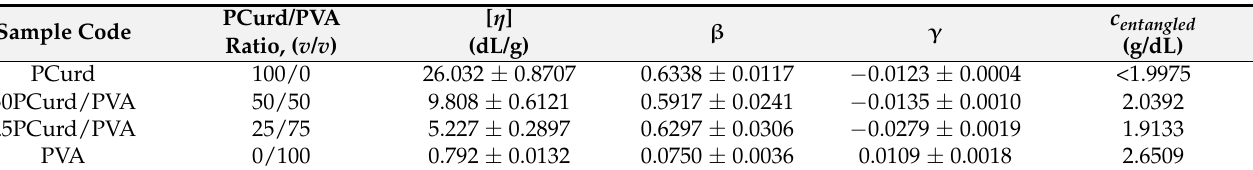
Table 1. The viscometric parameters determined for aqueous solutions of PCurd, PVA, and their mixtures at 25 ° C, according to Wolf model.